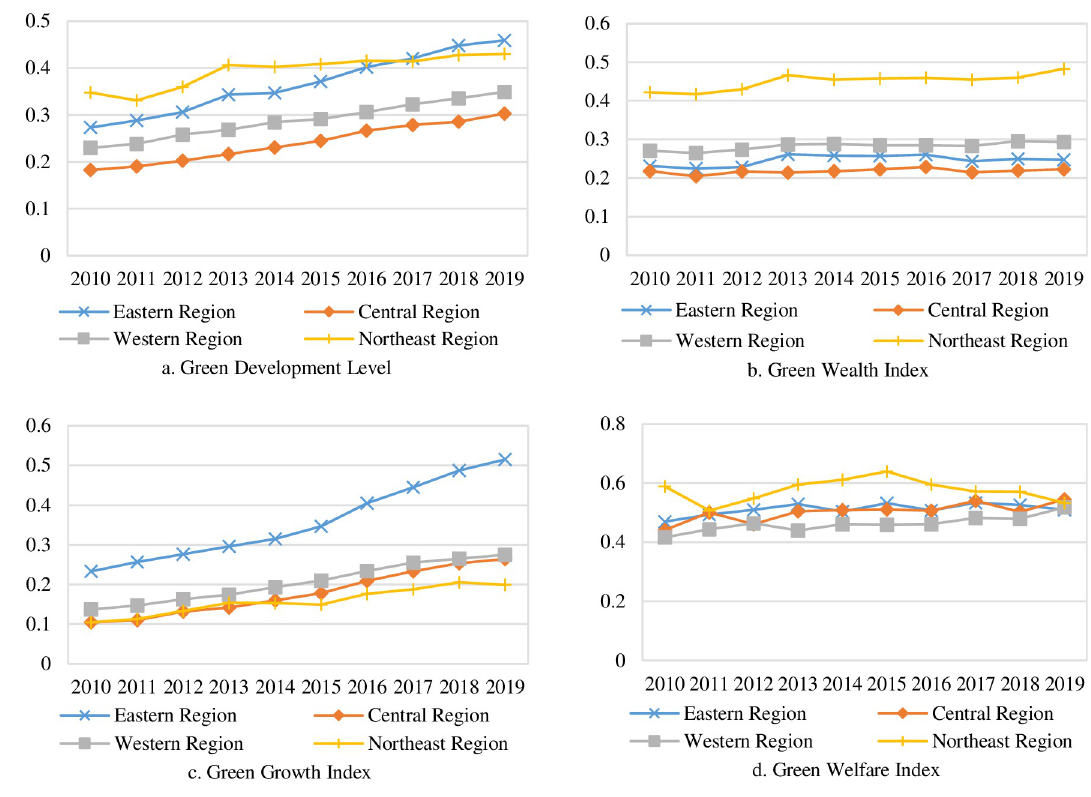
Fig 3. Trends of green development level and its composition in four major regions of China from 2010 to 2019.